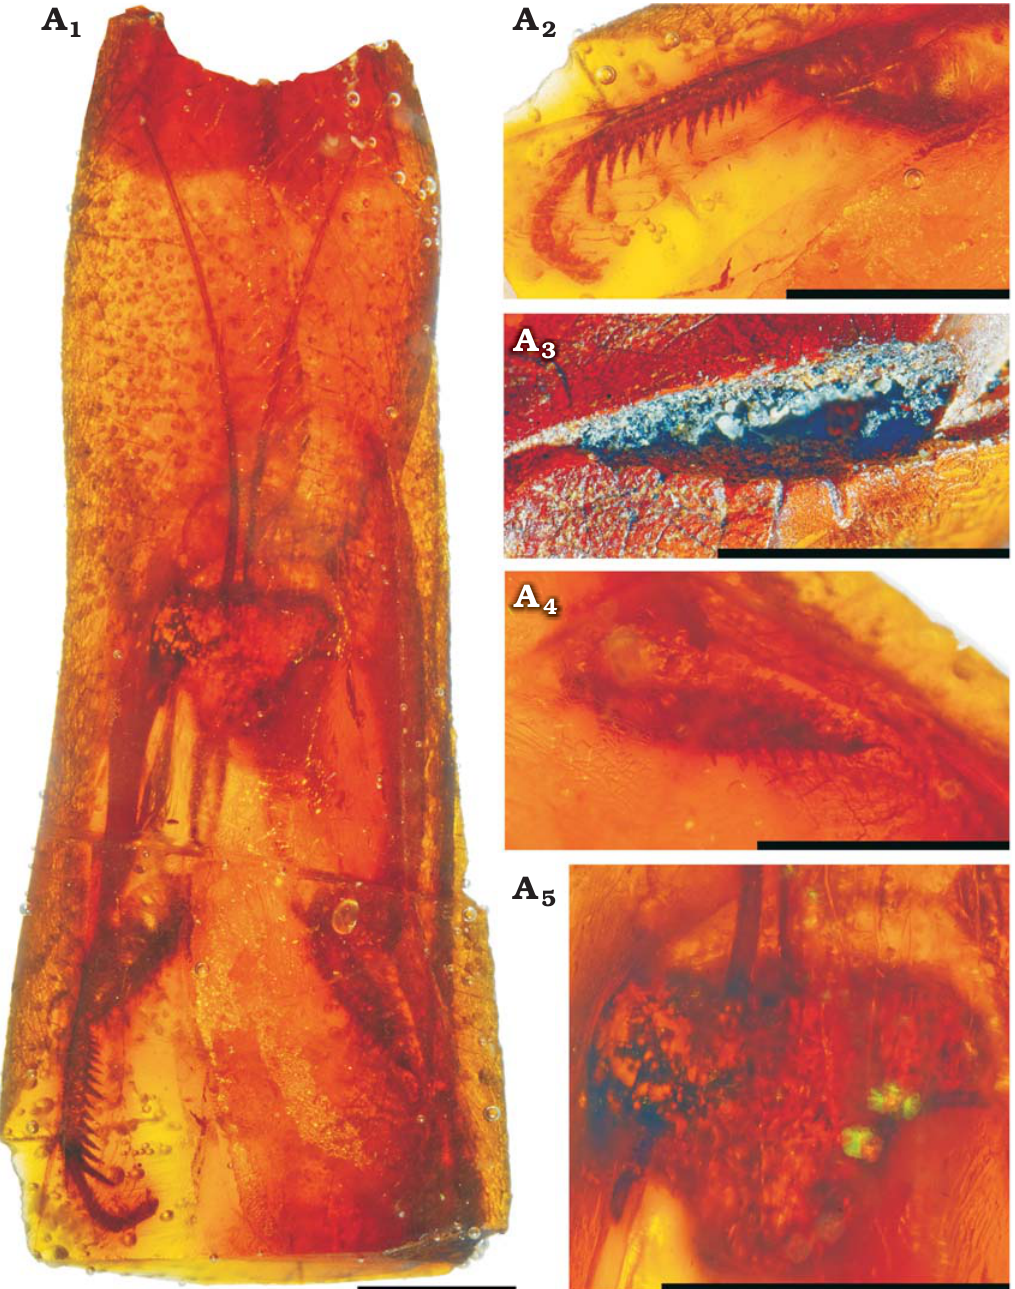
Fig. 1. Chaeteessidae gen. at sp. incertae sedis, MNHN-F.A71139, Le Quesnoy, France, Eocene. General habitus (A 1 ), right fore tibia (A 2 ), outer side of left fore femur (A 3 ), inner side of left fore femur (A 4 ), head (A 5 ). Scale bars 2